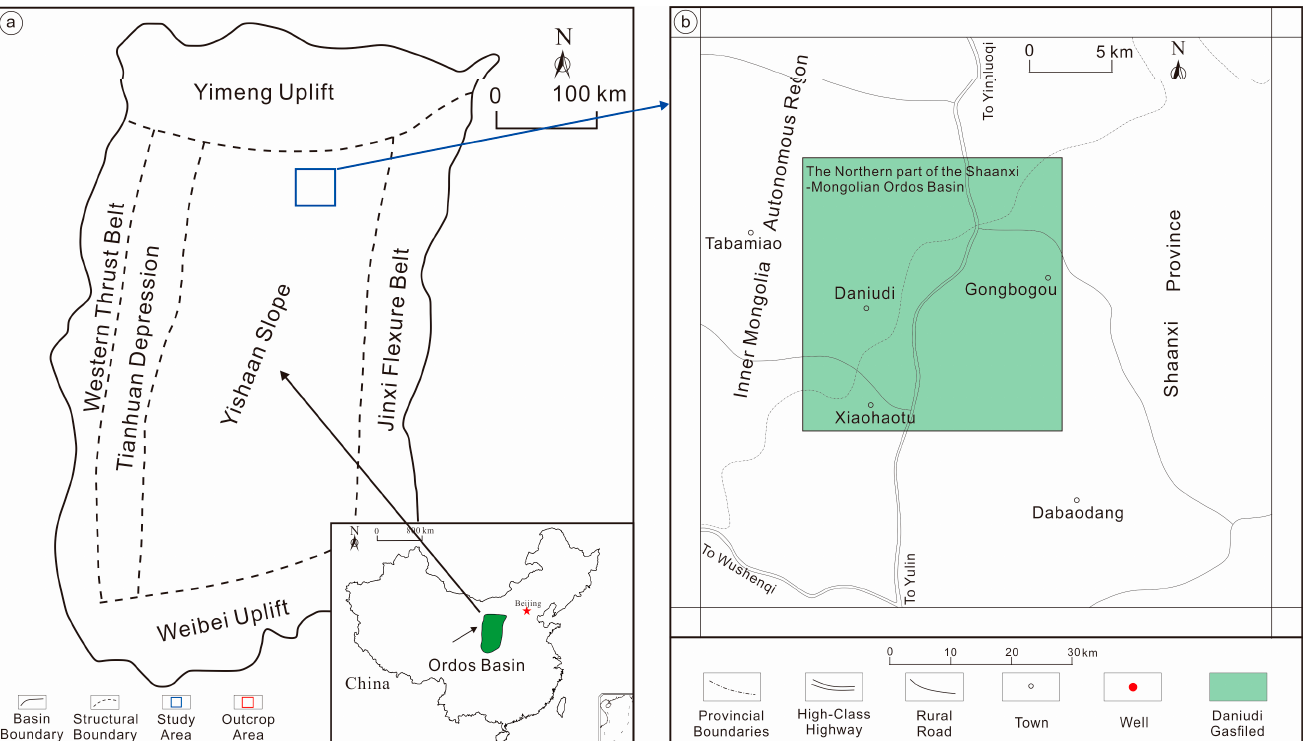
Figure 1. Location of study area. ( a ) The location of Ordos Basin (after Xu et al., 2019 [37]). ( b ) The location of Daniudi gas field in the research area (after Wu., 2013 [36]).